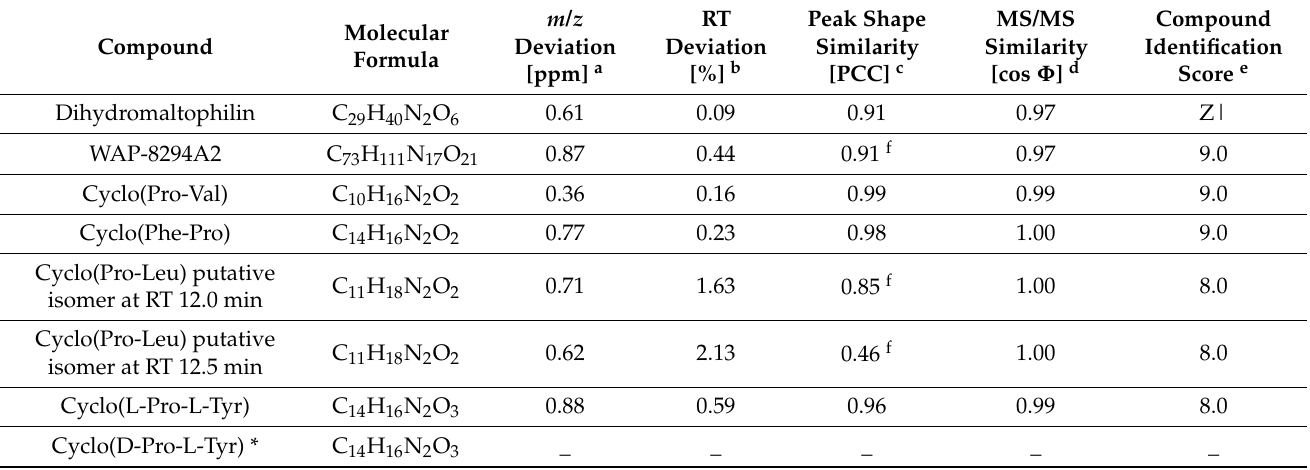
Table 3. Results from the in parallel ultra-high performance liquid chromatography-high resolution tandem mass spectrom- etry (UHPLC-HRMS/MS) analysis of Lysobacter capsici AZ78 (AZ78) extracts and reference